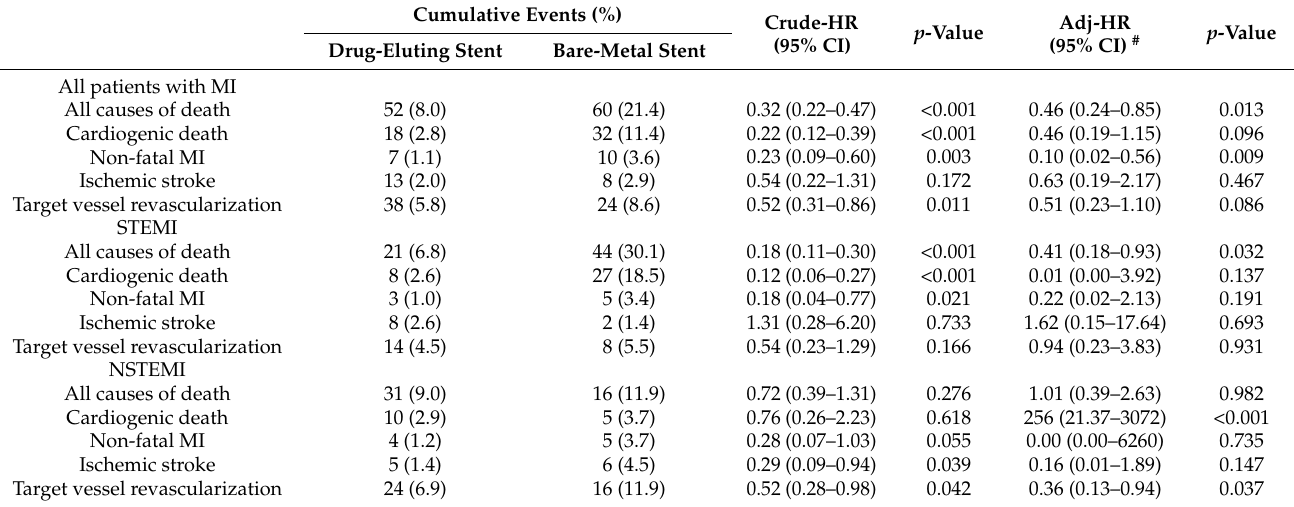
Table 2. Risk analysis of major cardiovascular incidents within 2